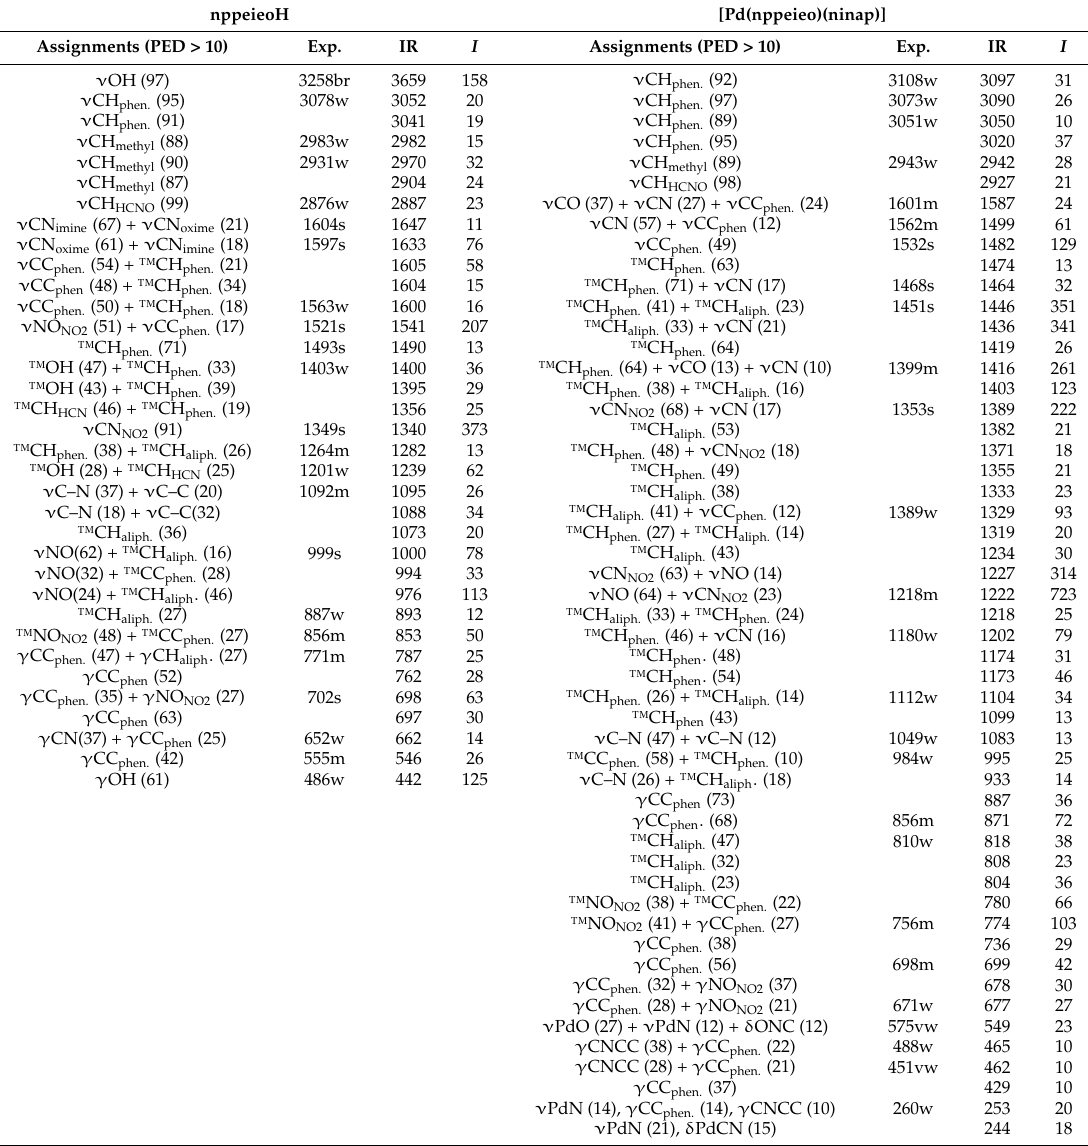
Table 3. Experimental and calculated FT-IR spectra for nppeieoH and its palladium(II) complex together with their assignment a (wavenumber in cm ´ 1